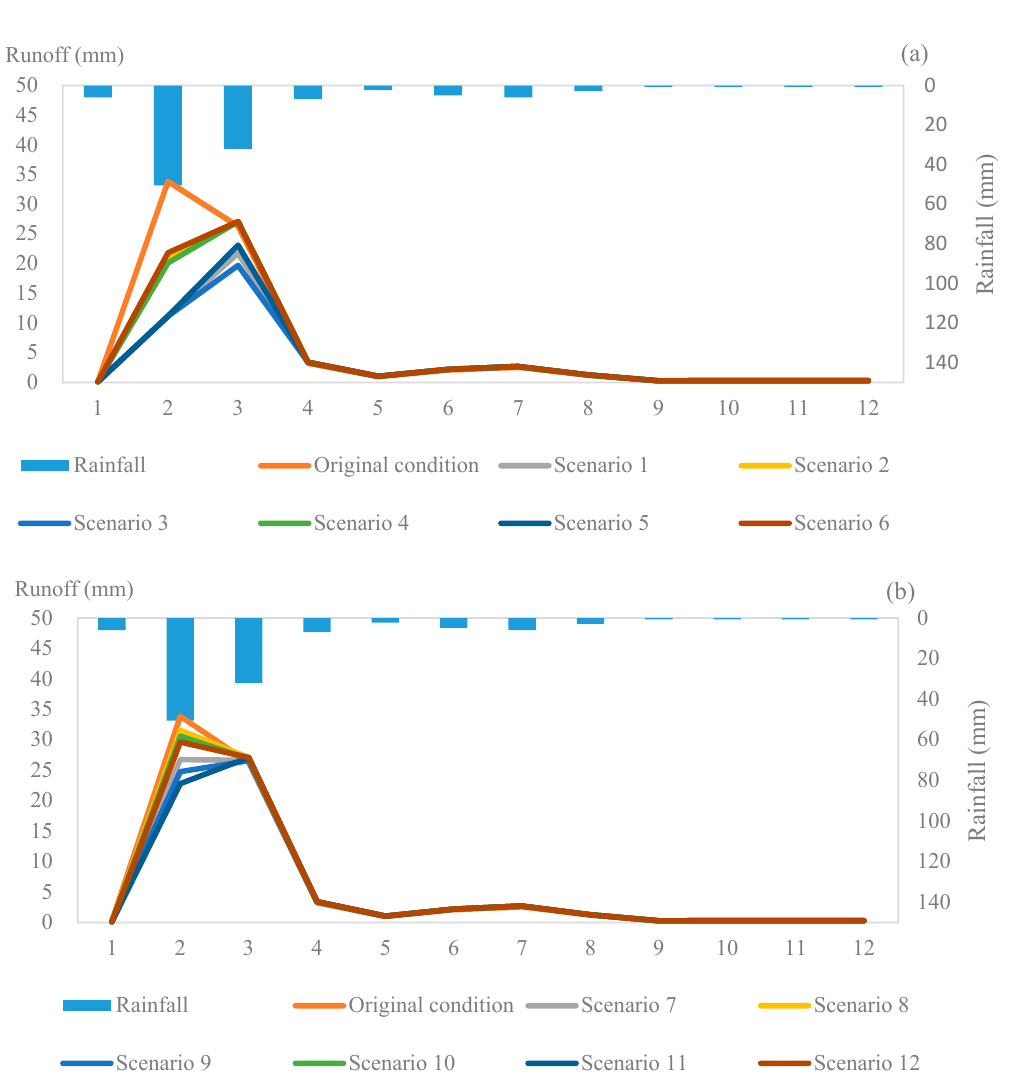
Figure 5. Simulated hourly surface runoff of original condition and all scenarios, ( a ) Scenarios 1–6; ( b ) Scenarios 7–12.